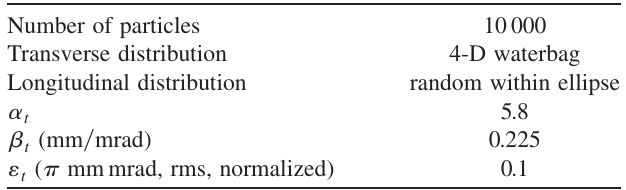
TABLE VI. Input beam parameters for a single beam RFQ linac in the PARMTEQM